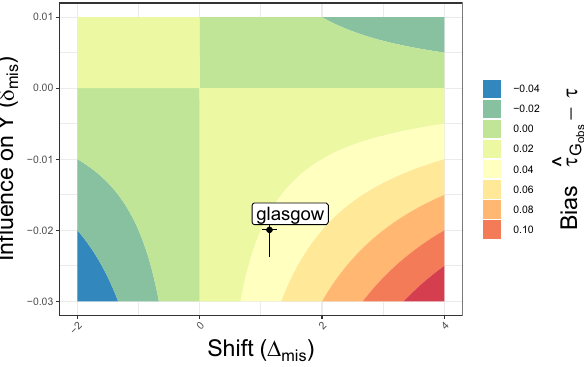
Figure 10: Sensitivity map if the Glasgow score covariate was missing : the true corresponding values for δ glasgow and Δ glasgow are computed with respectively a Robinson procedure and a mean di ff erence. Intervals correspond to 95% con fi dence